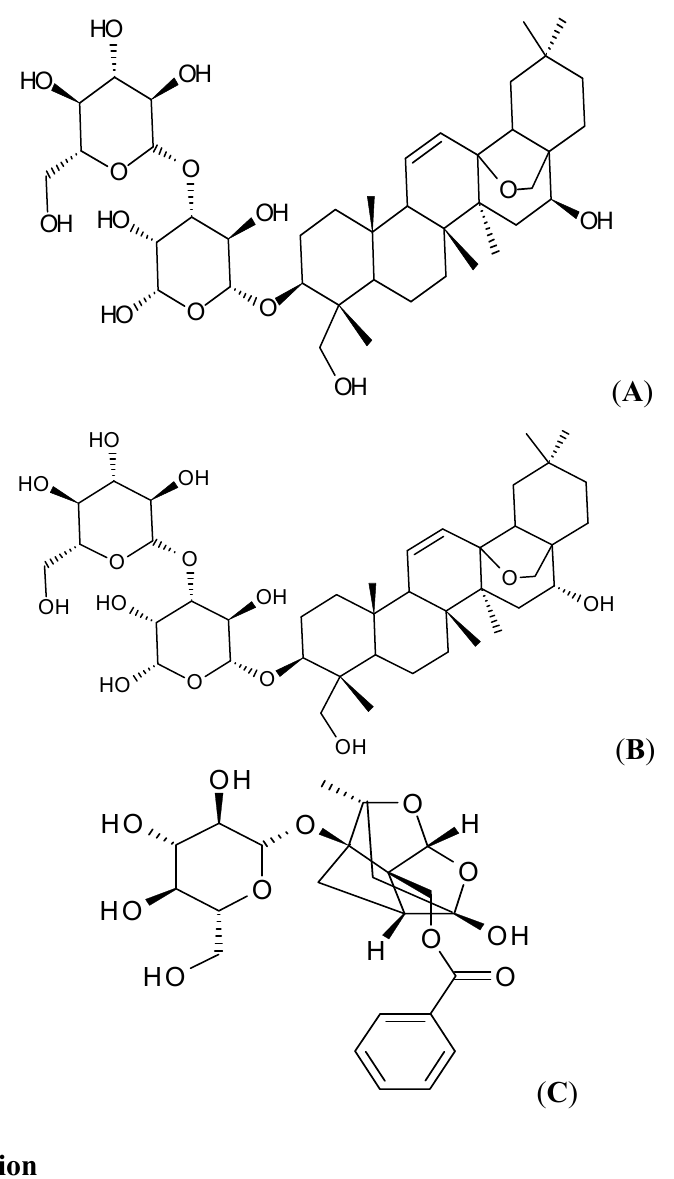
Figure 1. Chemical structures of SSA ( A ) SSD ( B ) and paeoniflorin ( C